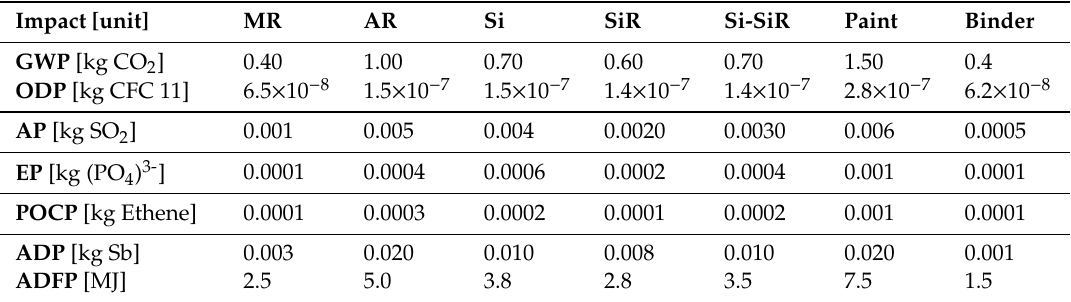
Table 5. Approximate values (average) of environmental impacts of products entering the ETICS system concerning 1 kg of product (2010–2016, ITB)–A1–A3 modules. MR—mineral render, AR—acrylic render, Si—silicone render, SiR—silicate render, Si-SiR—silicone-silicate render.